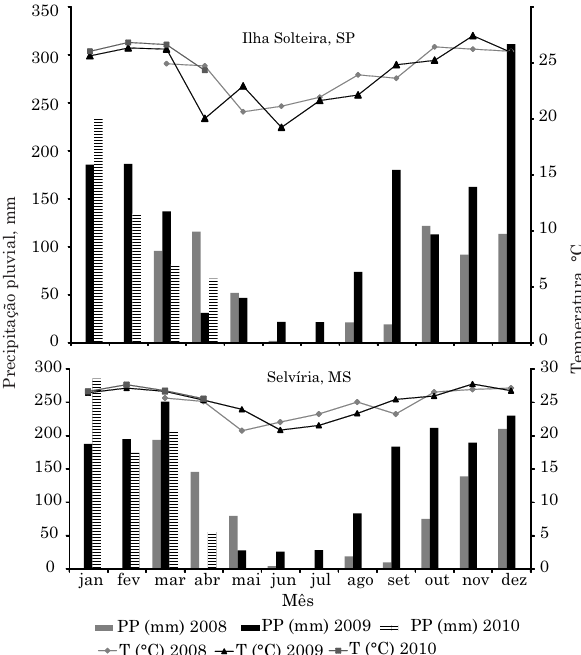
Figura 1. Dados de precipitação pluvial (PP) e temperatura média (T), em Votuporanga, SP e em Ilha Solteira, SP, localizada a 13,9 km de Selvíria, MS, no período estudado, março de 2008 a abril de 2010. Fonte: Ciiagro